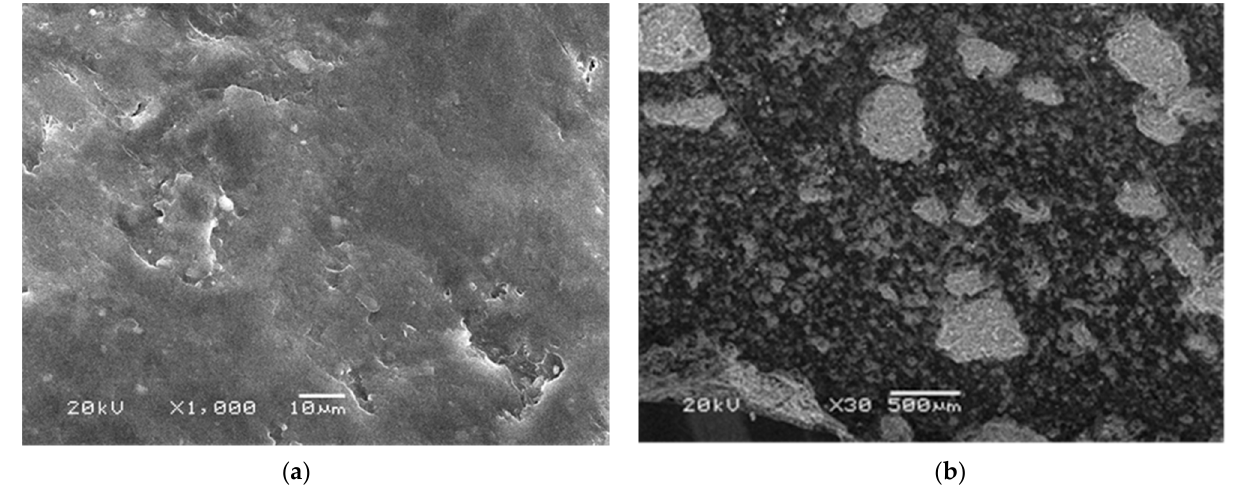
Figure 13. Surface of the board ( a ) 8 days after hydration and ( b ) 28 days after hydration. To elucidate the mechanism involved in why boards with starch (types A, B and C) have better properties than boards without starch (D and E), a micrograph of board type E2 (no starch, 20% cement and 2 h in the press) after 28 days of setting is shown in Figure 14.